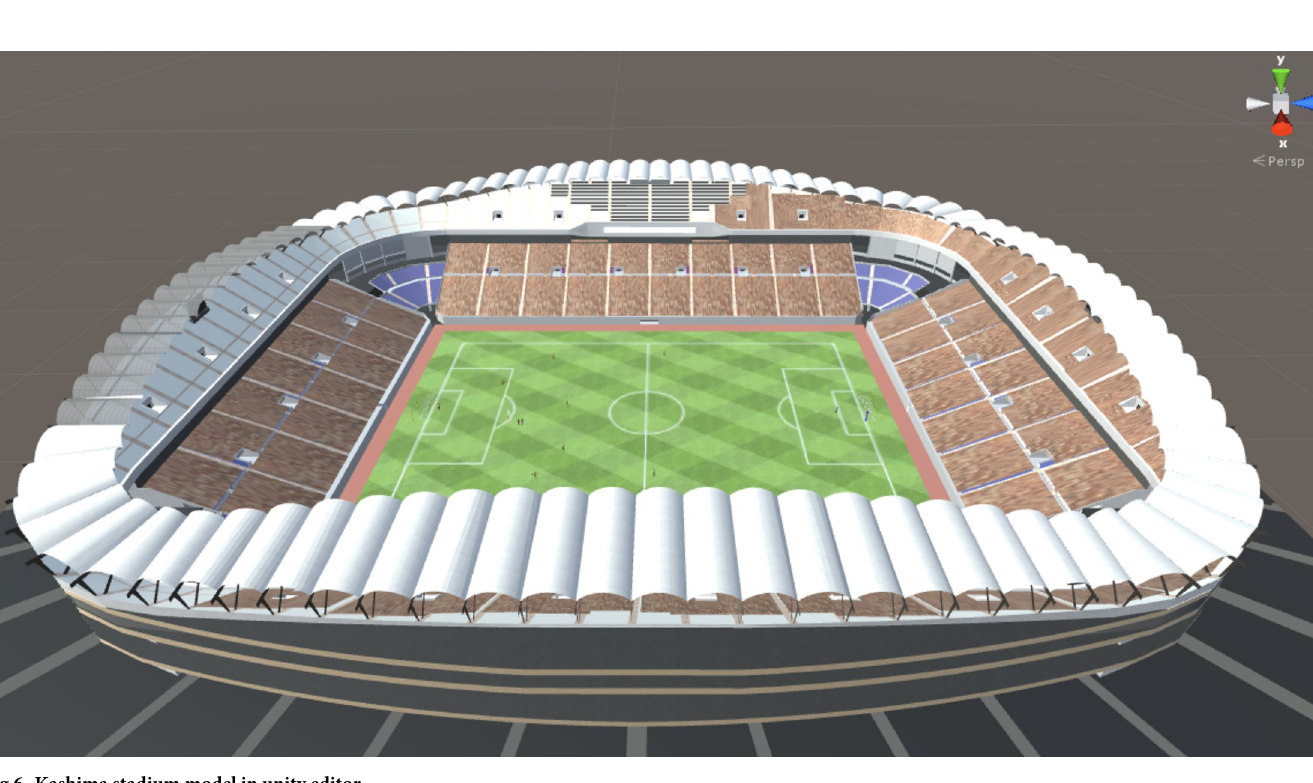
Fig 5. Goal post height measured with unity units, which are converted using a meter conversion tool. The real standard size is 2.44 m as established by FIFA.